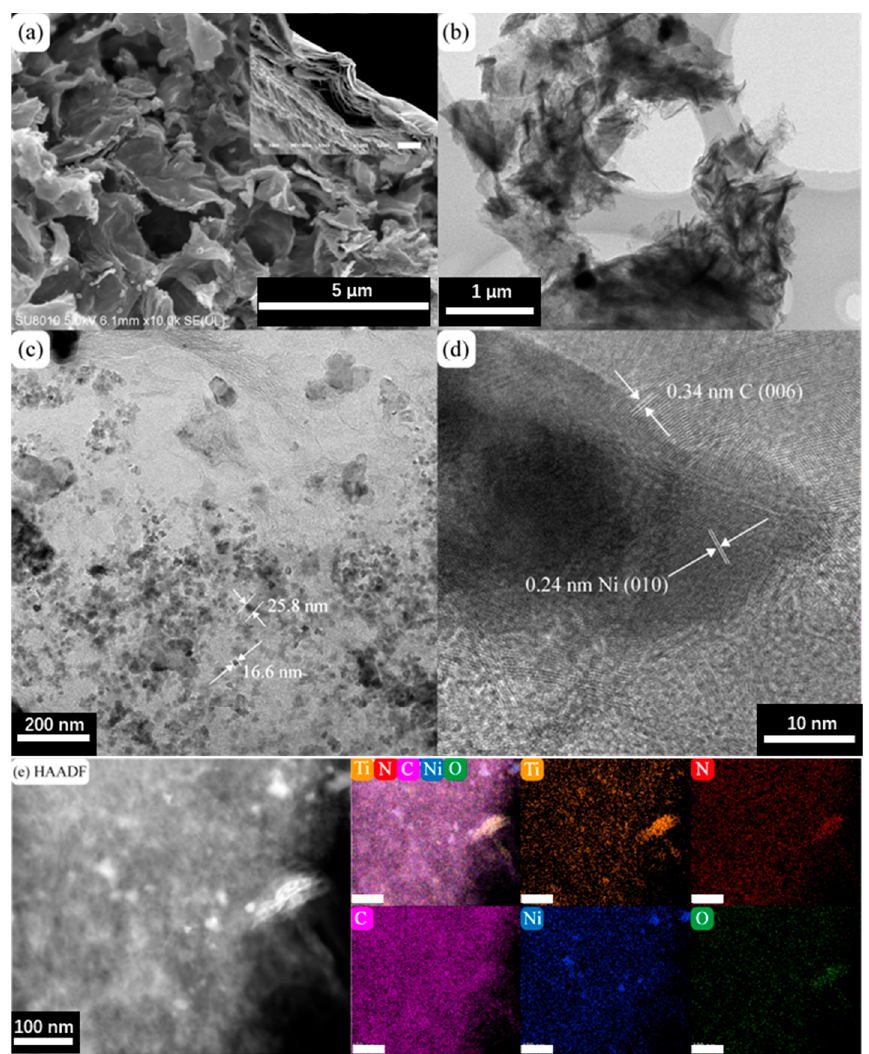
Figure 1. ( a ) SEM image and ( b ) TEM bright-field image of N-M@CNi. The insert is an SEM cross- section of a Ti3C2Tx filtrated film (scale bar, 5 μ m). ( c ) The TEM bright-field image of the carbon nanosheets showing the Ni nanoparticles and their typical diameters. ( d ) The HRTEM image of the Ni and C lattice fringes. ( e ) HAADF images and corresponding elemental maps of Ti, N, C, Ni, and O elements. The unlabeled bars in ( e ) represent 100 nm.